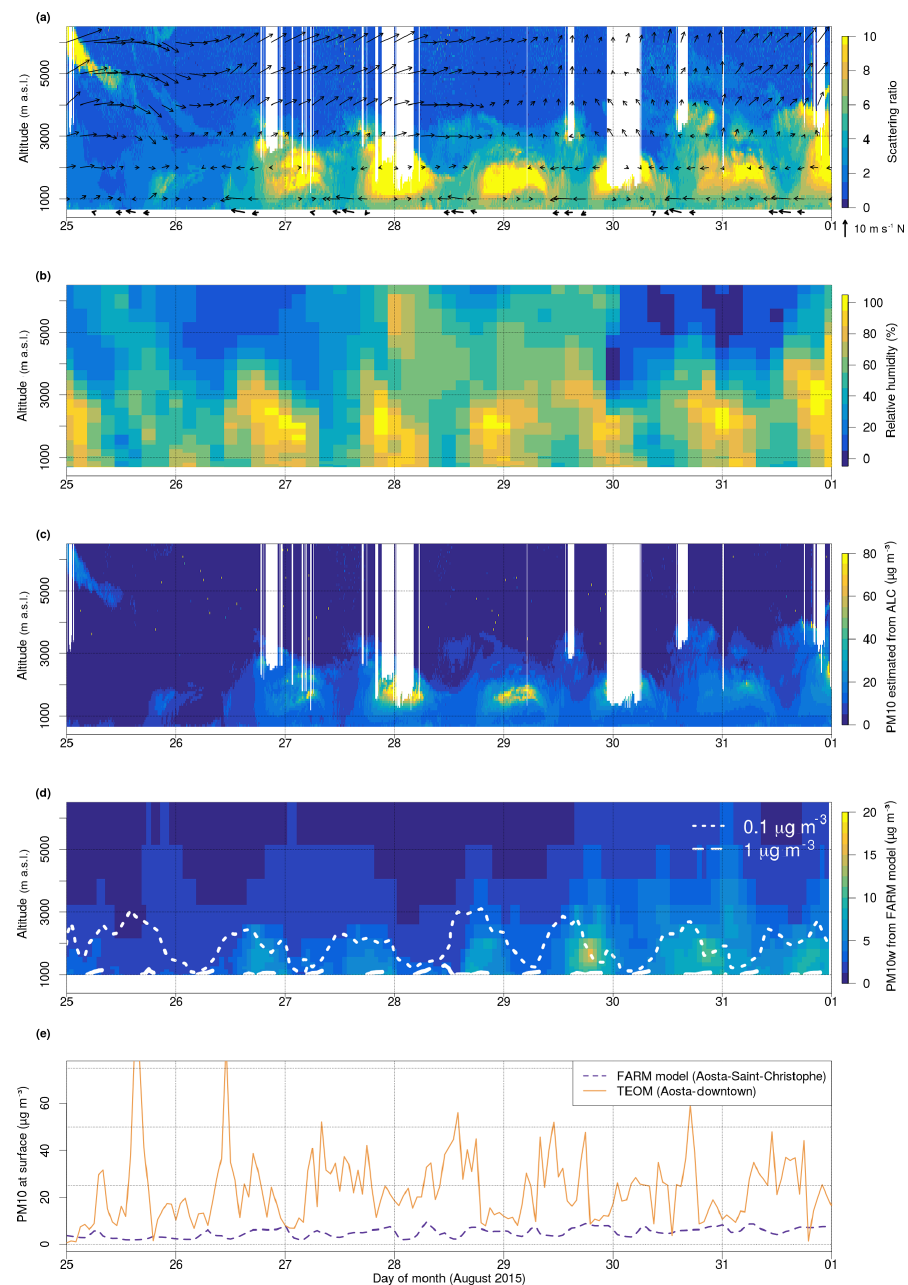
Figure 3. Case study of 25–31 August 2015. (a) Coloured background: vertical profile of scattering ratio from ALC in Aosta–Saint- Christophe. The signal above the clouds is plotted as white areas. Arrows: horizontal velocity of the wind measured at the surface (bold, lower arrows) and simulated by COSMO at several elevations (thin arrows). Calm wind (speed < 1ms − 1 ) is not plotted. A reference ar- row for a 10ms − 1 wind blowing from the south to the north is drawn at the bottom right corner. (b) Vertical profile of relative humidity forecasted by COSMO. (c) Vertical profile of PM 10 mass concentration derived from ALC. (d) Mass concentration (PM 10w ) from FARM. PM concentration from non-local sources is represented by the coloured background (the colour scale is chosen to better show the daily pattern simulated by the model) and the effect of local sources by the contour line, at logarithmic steps (dotted: 0.1µgm − 3 ; dashed, near the surface: 1µgm − 3 ). (e) Hourly PM 10 (dry) surface concentration from FARM simulations in Aosta–Saint-Christophe and observations in Aosta–downtown, for the purpose of checking if any sudden variation in surface air quality data is